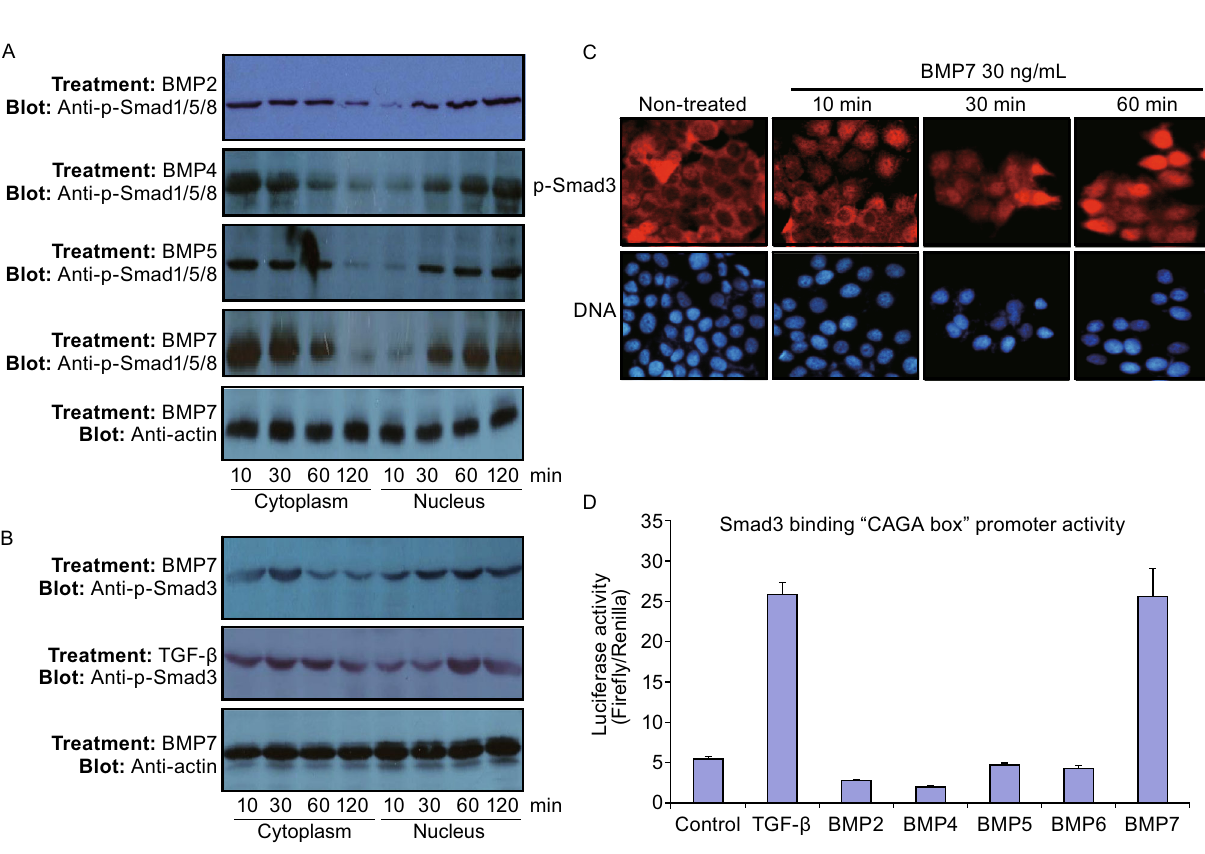
mediating BMP7-induced breast cancer cell senescence as well as apoptosis. BMP4 and BMP5 (Fig. 5A). In a preliminary experiment, we observed no apparent effect of Smad1, Smad5 and Smad8 on telomerase inhibition (not shown). However, we found surprisingly that Smad3 responded to BMP7. As shown in Fig. 5B, incubation of cultured MCF-7 cells with BMP7 for different periods of time from 10 min to 2 h resulted in Smad3 phosphorylation. The phosphorylation was gradually increased and the maximal levels of phosphorylation were two-thee folds of that under basal conditions in a time-